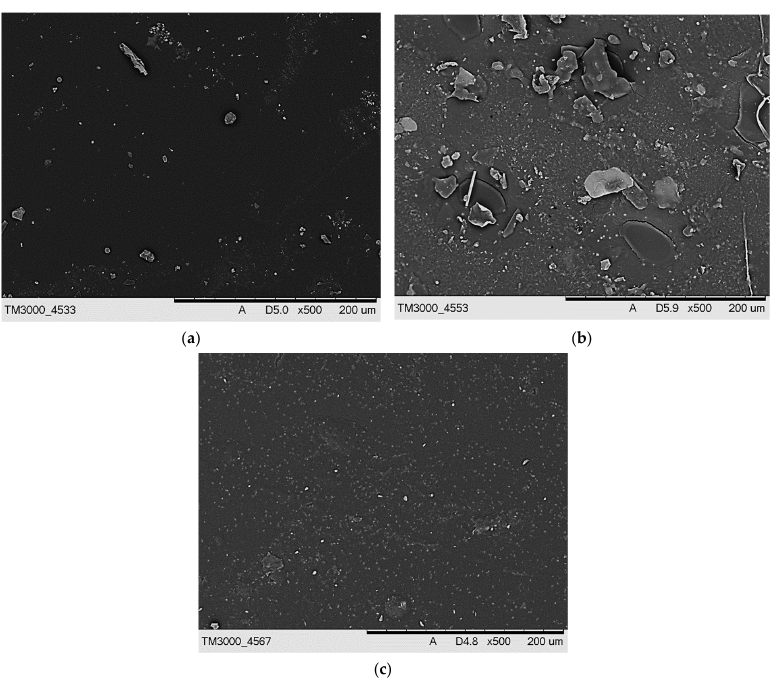
Figure 10. SEM image of sample 700/7.5 ( a ), 700/10.0 ( b ), and 700/12.5 ( c ).